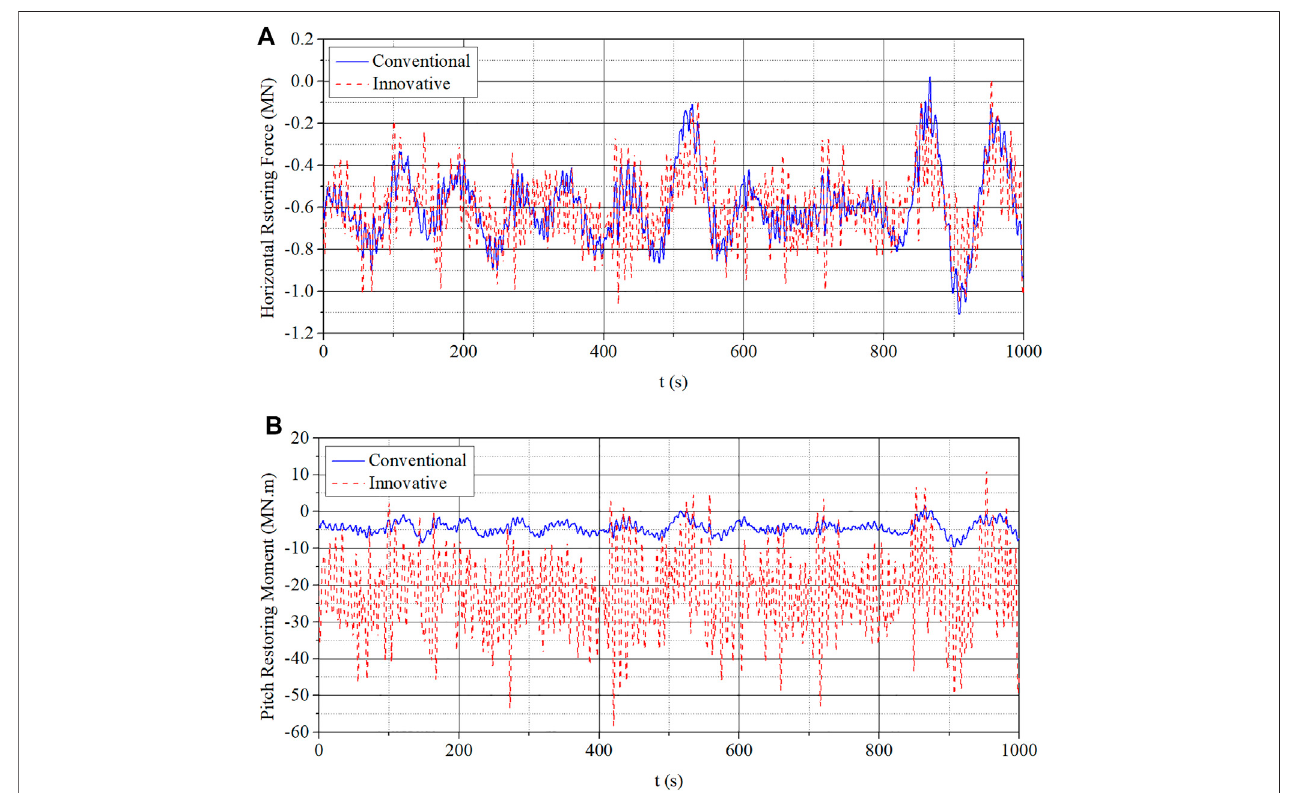
TABLE 6 | Restoring force and moment statistics (absolute values) Items Conventional Innovative Increasing ratio (%) Horizontal restoring forces